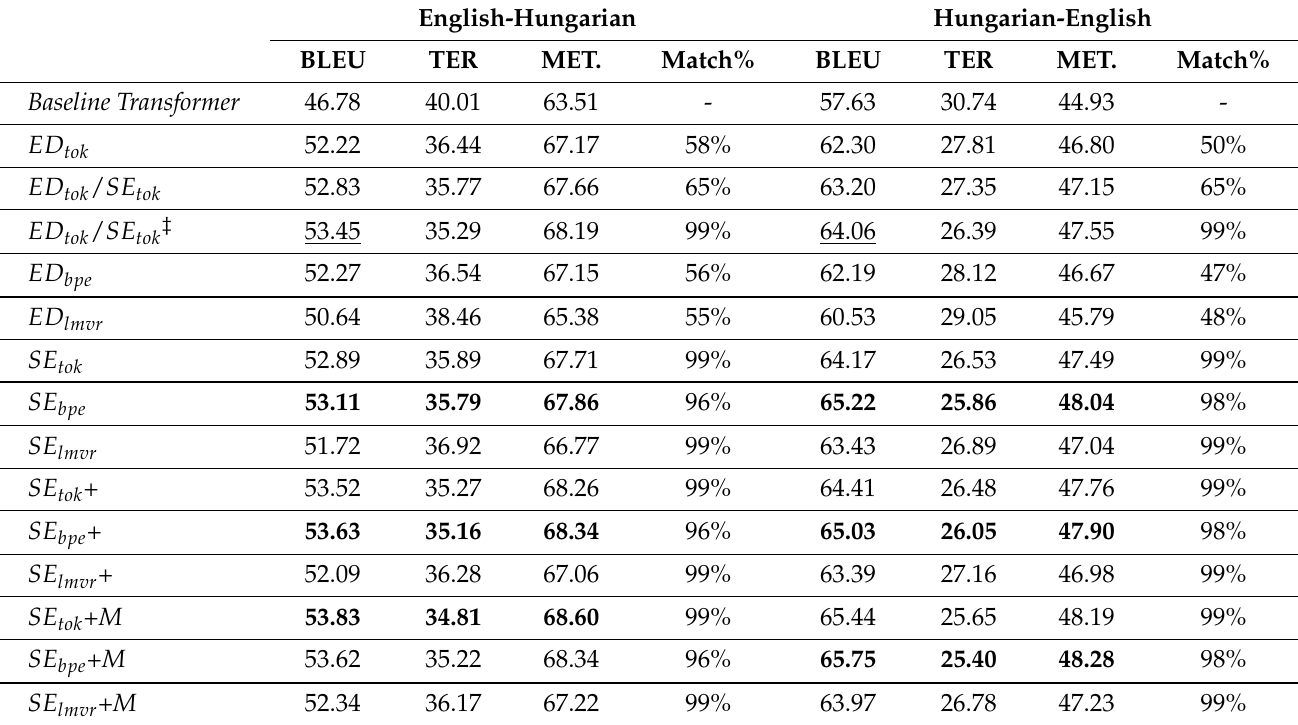
Table 4. Results of the automated evaluations for English ↔ Hungarian. Match% refers to the percentage of test sentences augmented with matches. Best scores are highlighted per table section (underlined for baselines, bold for tested